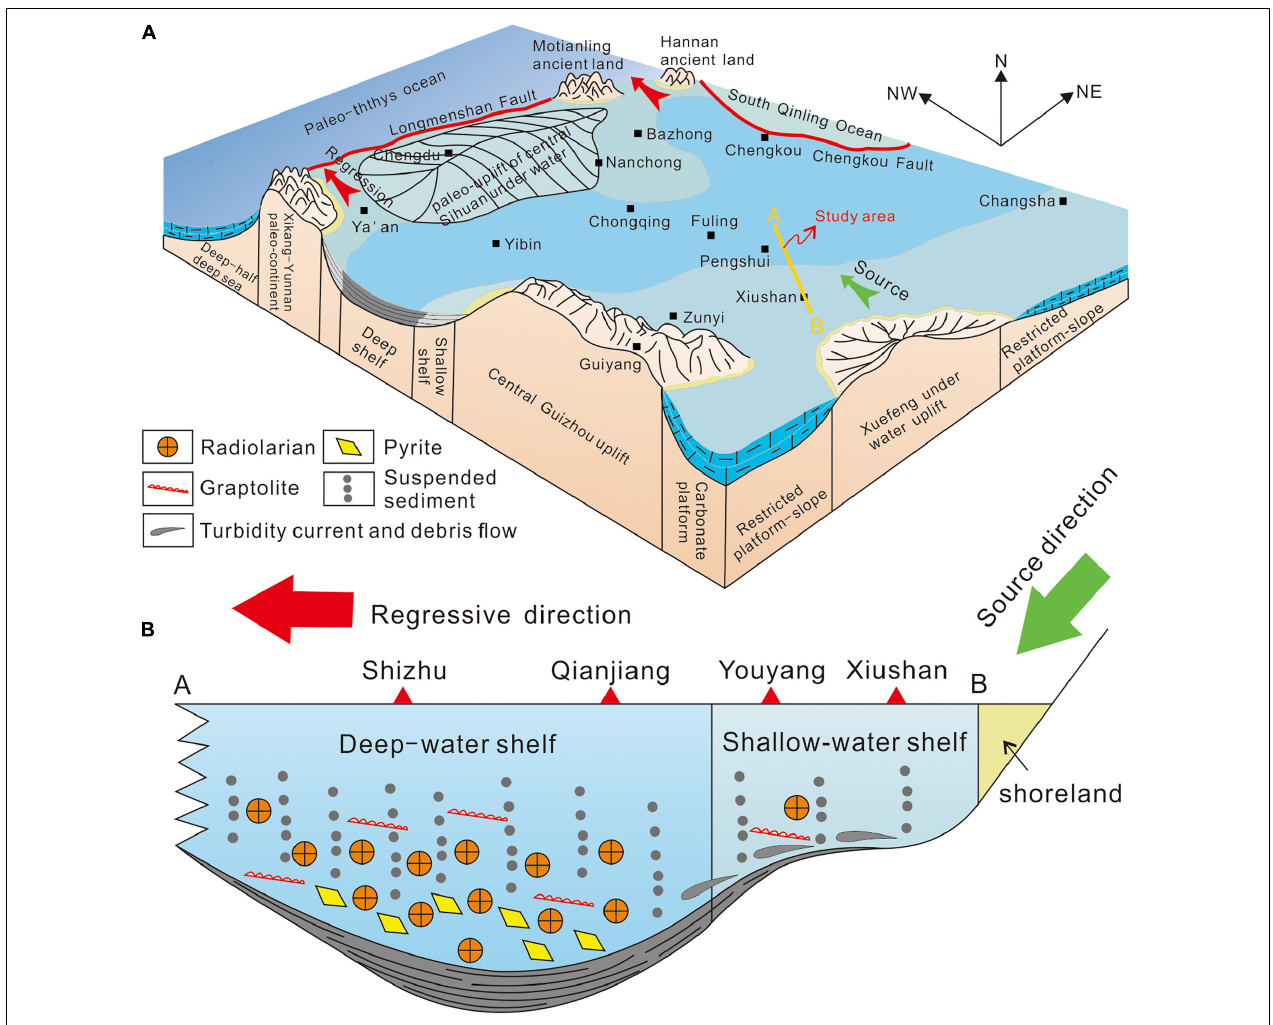
FIGURE 10 | (A) Late Ordovician–Early Silurian sedimentary environment model map of the Sichuan Basin and its periphery (modified from Fan et al., 2019); (B) sedimentary environment distribution model map of the Wufeng–Longmaxi Formation in southeastern Chongqing (modified from Liang et al.,